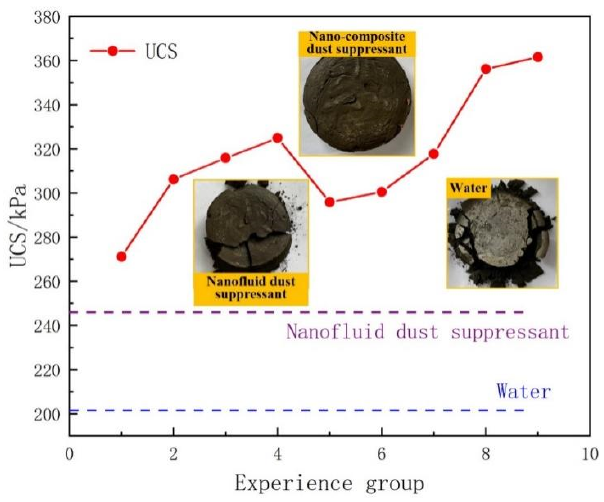
Figure 7. Test results of the UCS.